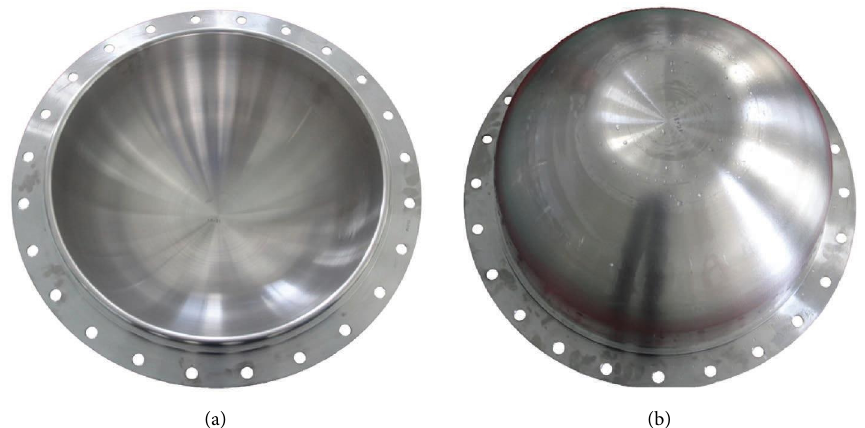
Figure 4: Initial titanium diaphragm (a) and the deformed ones when rolled fully (b).